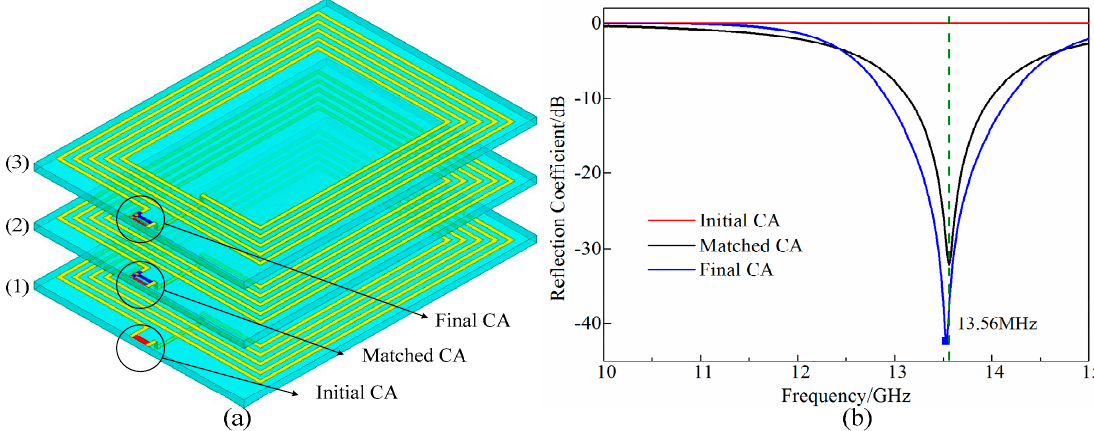
Figure 12. ( a ) A sandwich model presenting the evolution of miniaturizing coil antenna; ( b ) comparison of S-parameters.